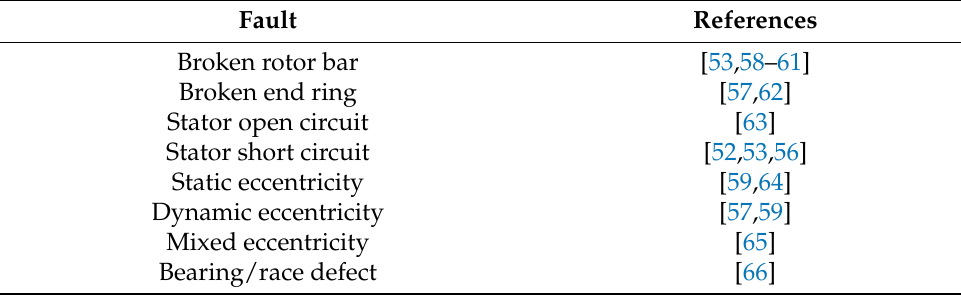
Table 2. d-q reference for different types of